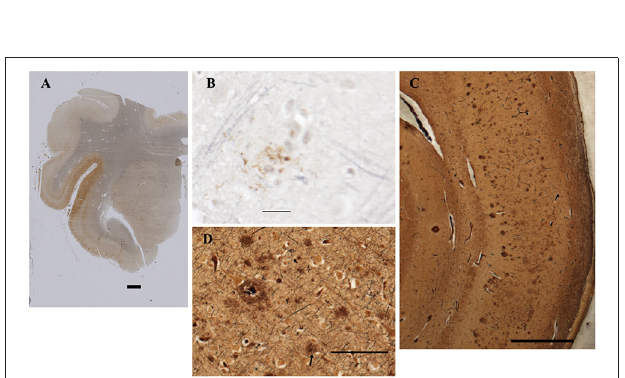
FIGURE 5 | Detection of amyloid plaques in the patient’s CNS. (A) Amygdala and rostral hippocampus, entorhinal cortex, and transentorhinal cortex. AT8 immunohistochemistry with Verhoeff myelin counterstain. BAR = 2mm. (B) Rare cortical neuritic plaque in middle frontal gyrus. AT8 with Verhoeff myelin counterstain. BAR = 20 microns. (C) Bielschowsky stain of CA1 and subiculum demonstrates numerous amyloid plaques. Bar = 1mm. (D) Bielschowsky stain of frontal cortex. Amyloid plaques predominate; rare neuritic plaques are also present (arrow). Bar = 100 microns.